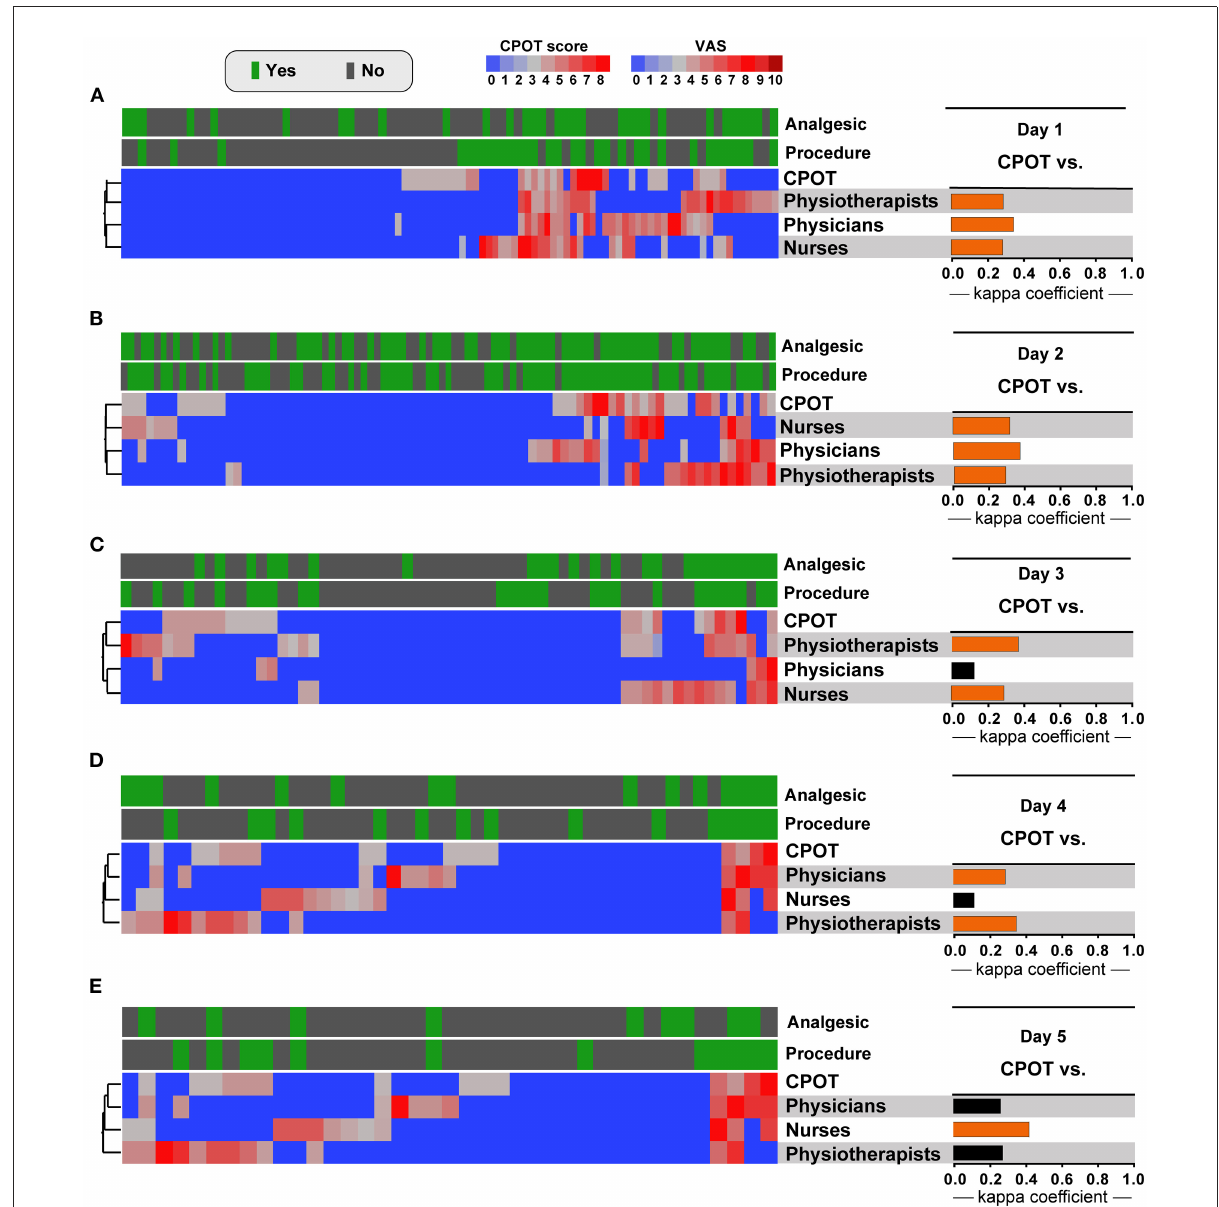
FIGURE2 Pain assessment profile by nurses, physicians and physiotherapists and results of CPOT score in ICU patients stratified by analgesics treatment and medical procedures. The kappa coefficient of agreement between the CPOT score and pain assessment by nurses, physicians,